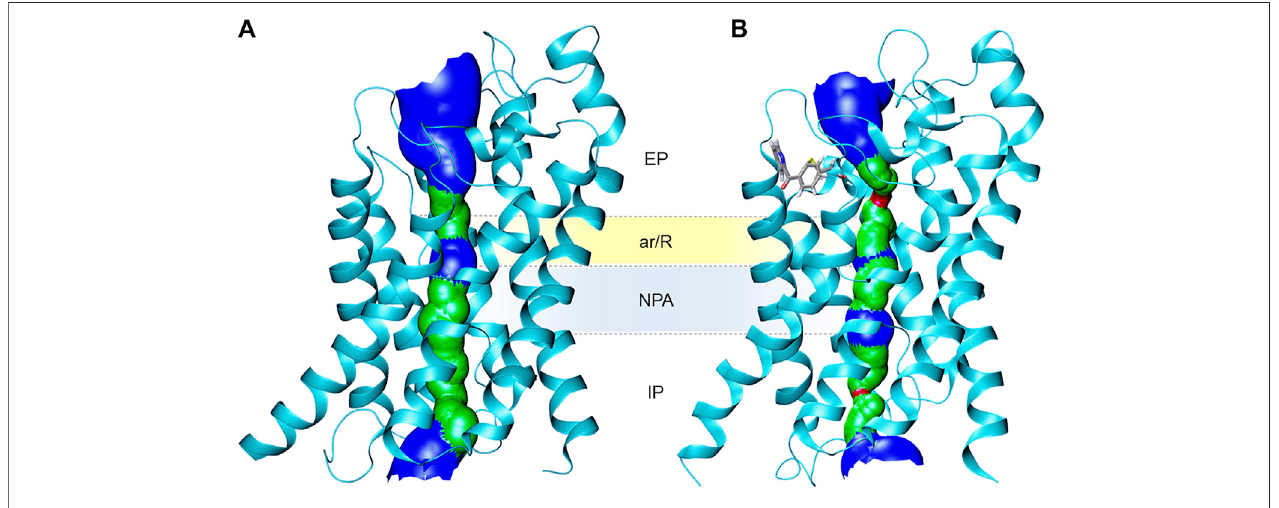
FIGURE6 | Ribbon representation of (A) the human AQP10monomer and (B) the AQP10-C ^ N adduct with modi fi ed Cys209, showing the effects ofpore size asa 3D representation (based on VDW radius: red = smaller than single H 2 O, green = single H 2 O, blue = larger than single H 2 O). Cys209-C ^ N fragment is shown in stick representation with atoms coloured by atom type (red = oxygen, blue = nitrogen, grey = carbon, yellow = sulfur). Figure generated using HOLE (Smart et al., 1996) and VMD software (Humphrey et al.,